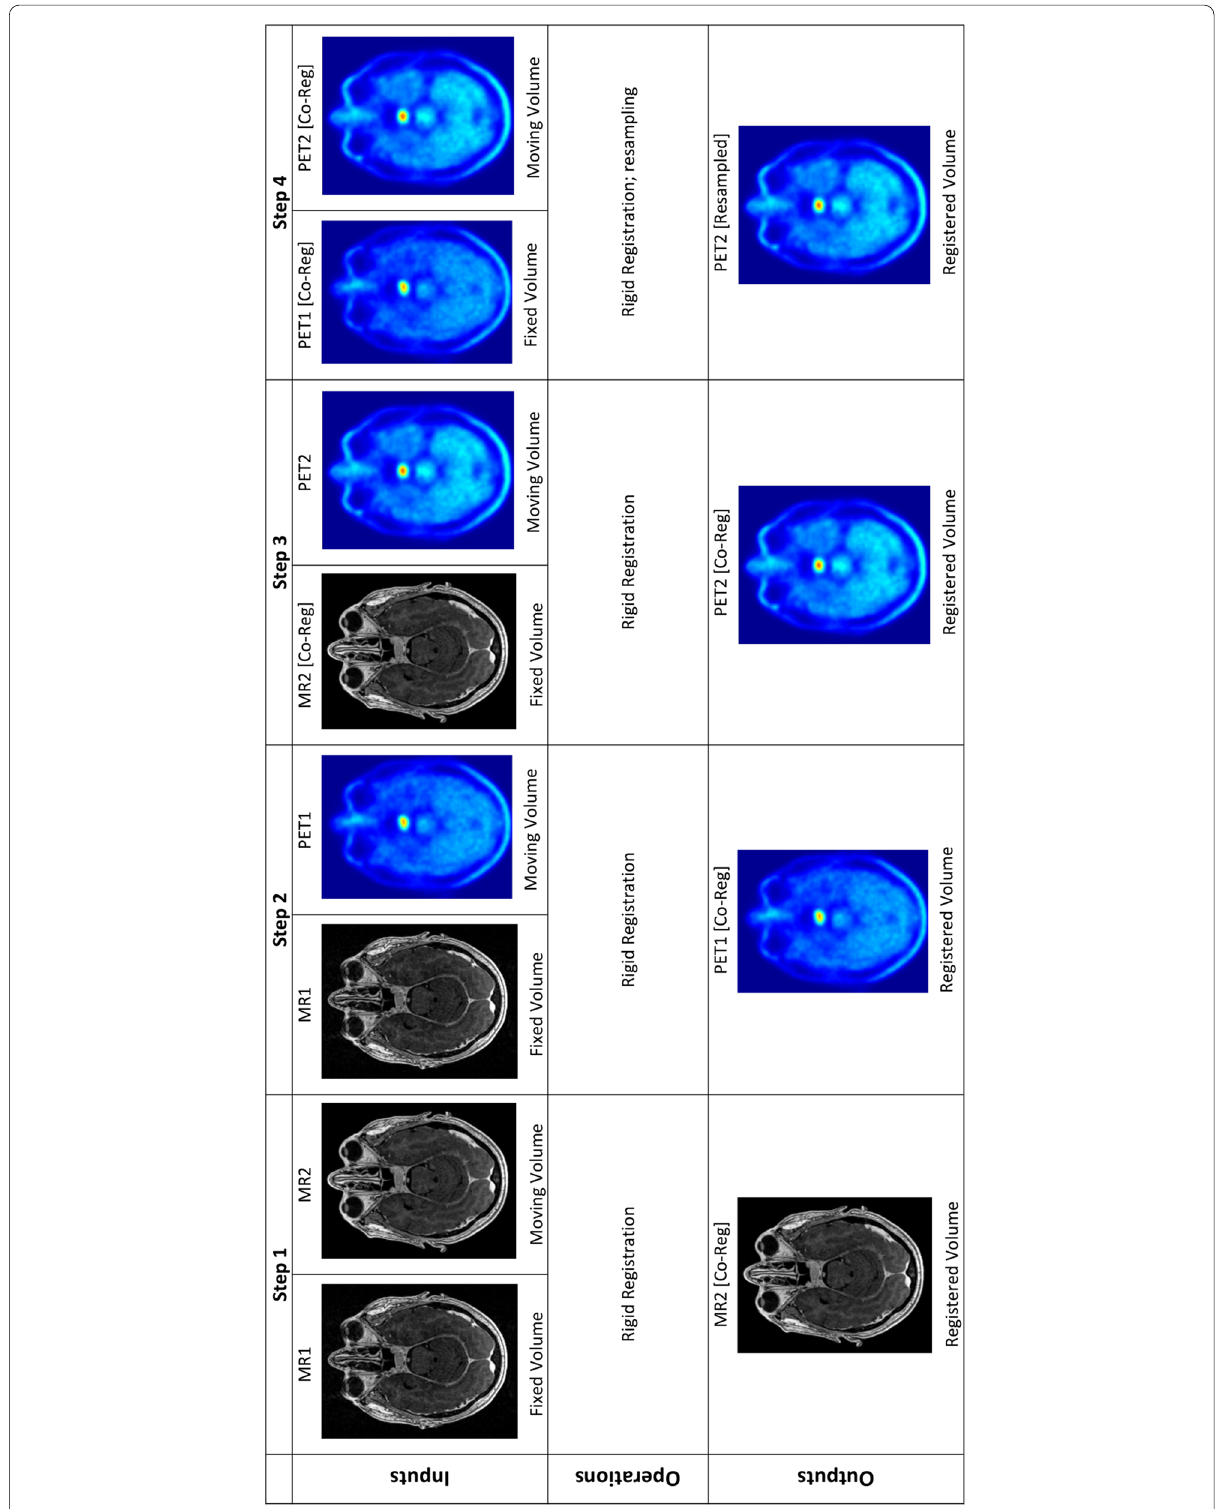
Fig. 1 Registration steps. Step 1: MR2 is registered to MR1 using rigid registration. Step 2: PET1 is registered to MR1 using rigid registration. Step 3: PET2 is registered to MR2 [Co-Reg]. Step 4: PET2 [Co-Reg] is registered to PET1 [Co-Reg] and resampled into a matrix of the same size and